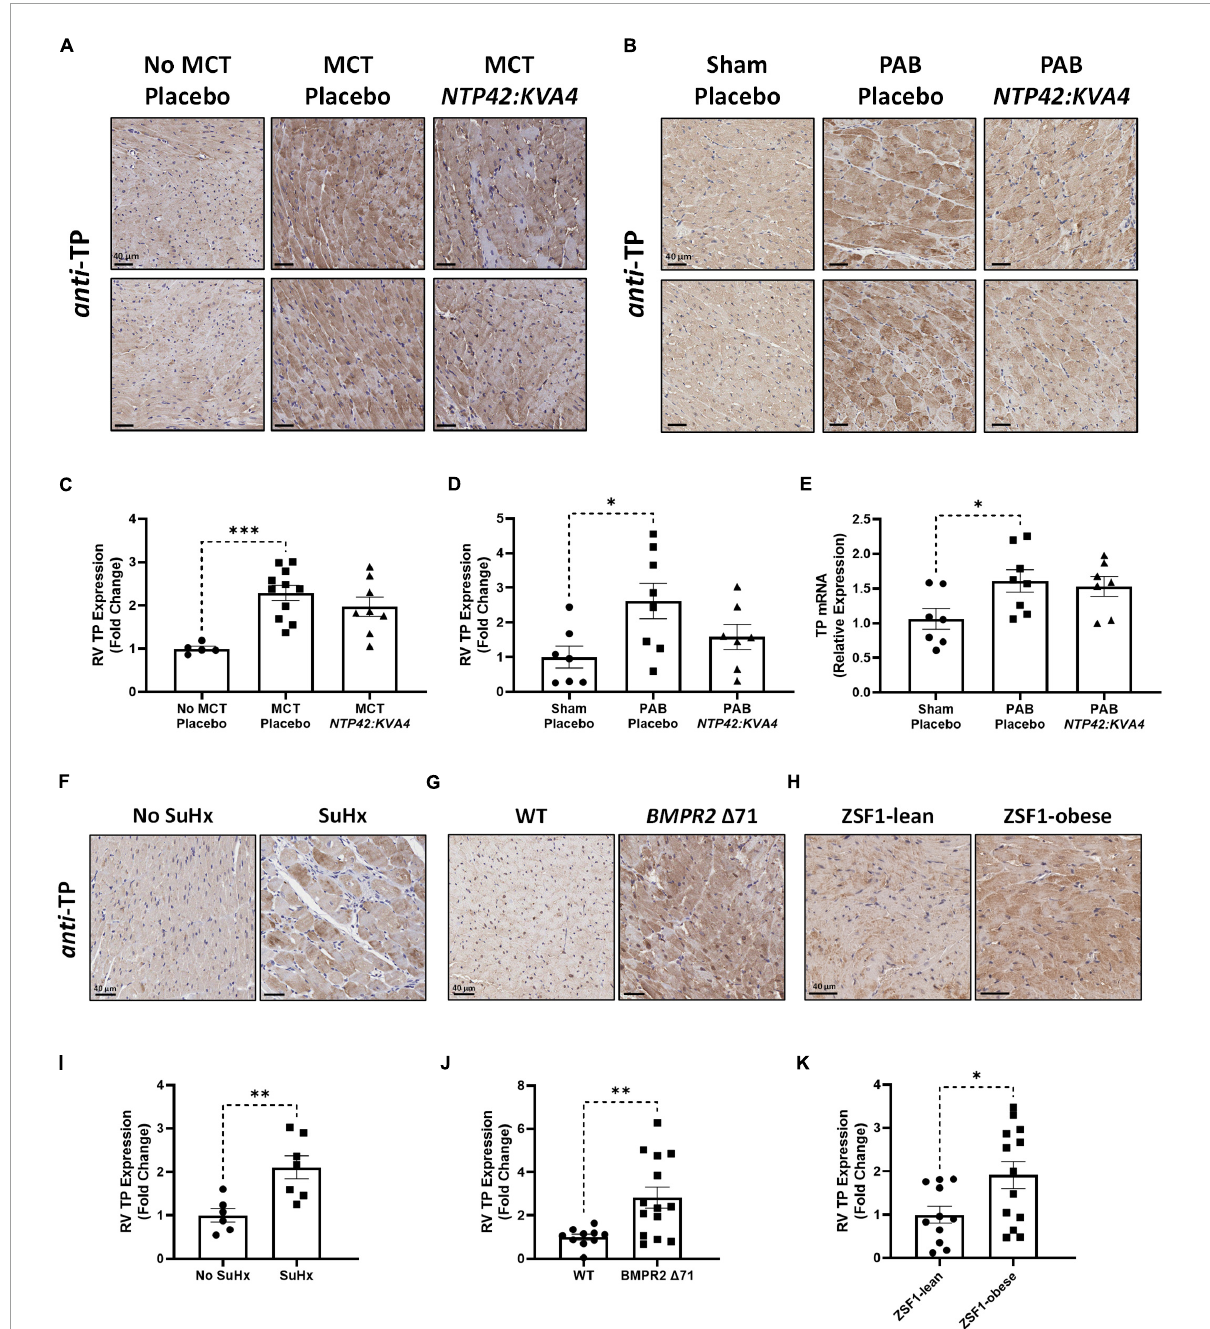
FIGURE6 RV expression of the TP in preclinical models of PAH and RV dysfunction. (A,B) Show two representative photomicrographs, selected from a random animal from each treatment group, of anti -TP-stained RV tissue from the: (A) MCT-PAH model, and (B) PAB model, where images were captured at 400 × magnification (scale bars represent 40 µ m). (C) Shows relative immunohistochemical (IHC) expression of the TP in the MCT-PAH model in RV tissue from animals of the “No MCT—Placebo,” “MCT—Placebo,” and NTP42:KVA4 groups [ n = 5, 11, and 8, respectively]. (D–E) Show: (D) relative TP IHC expression in the PAB model in RV tissue from animals of the “Sham—Placebo,” “PAB—Placebo,” and NTP42:KVA4 groups [ n = 7, 8, and 7, respectively], and (E) RV TP mRNA expression [ n = 7, 8, 7]. (F–H) Show representative photomicrographs, selected from a random animal from each treatment group, of anti -TP-stained RV tissue from: (F) Control groups of a previously described SuHx-PAH model (28), namely “No SuHx” and “SuHx,” where normal control rats (“No SuHx”) and rats treated with SuHx (“SuHx”) were treated PO BID with vehicle upon removal from hypoxia and continuing in normoxia until Day 49 (i.e., 4 weeks duration); (G) BMPR2 (cid:49) 71 rats or their WT counterparts, and (H) ZSF1-obese rats or their lean counterparts (ZSF1-lean). (I–K) show relative expression levels of the TP in RV tissue from: (I) “No SuHx” and “SuHx” animals [ n = 6 and 7, respectively]; (J) WT or BMPR2 (cid:49) 71 animals [ n = 14 and 11, respectively], and (K) ZSF1-lean or ZSF1-obese animals [ n = 13 and 11, respectively]. Data presented are the mean ± SEM. * P < 0.05, ** P < 0.01, *** P < 0.001 vs. the respective disease control group in each case according to one-way ANOVA with Holm-Šídák correction (A–C) or unpaired Student’s t -tests (I–K)